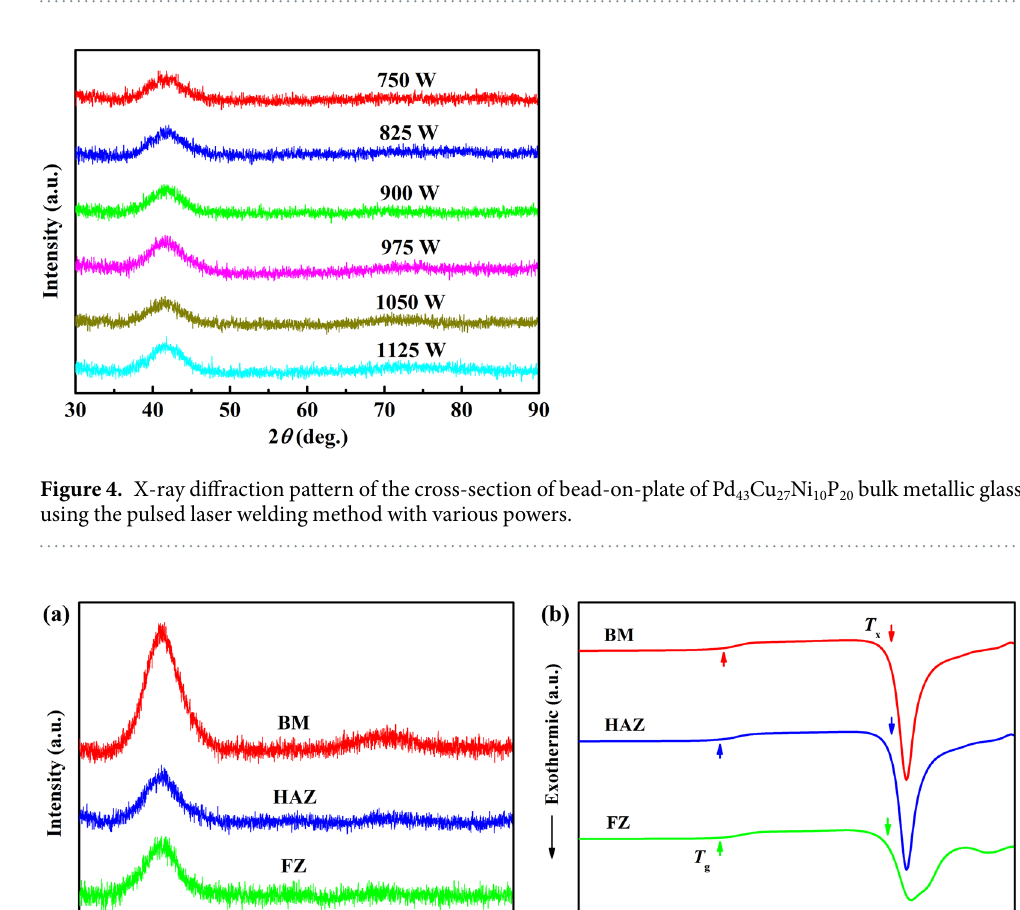
Figure 3. Morphology of bead-on-plate of Pd 43 Cu 27 Ni 10 P 20 bulk metallic glass obtained by the pulsed laser welding method under 1050 W laser beam power.